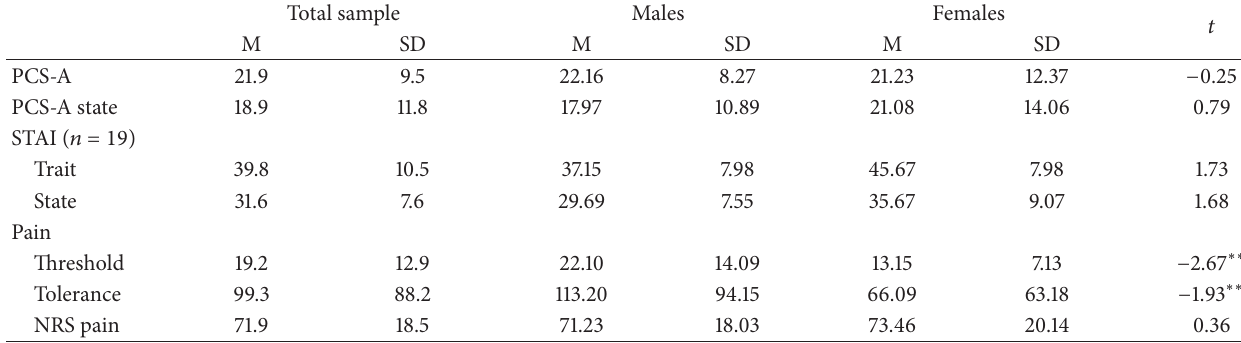
Table 4: Means and standard deviations for study variables.